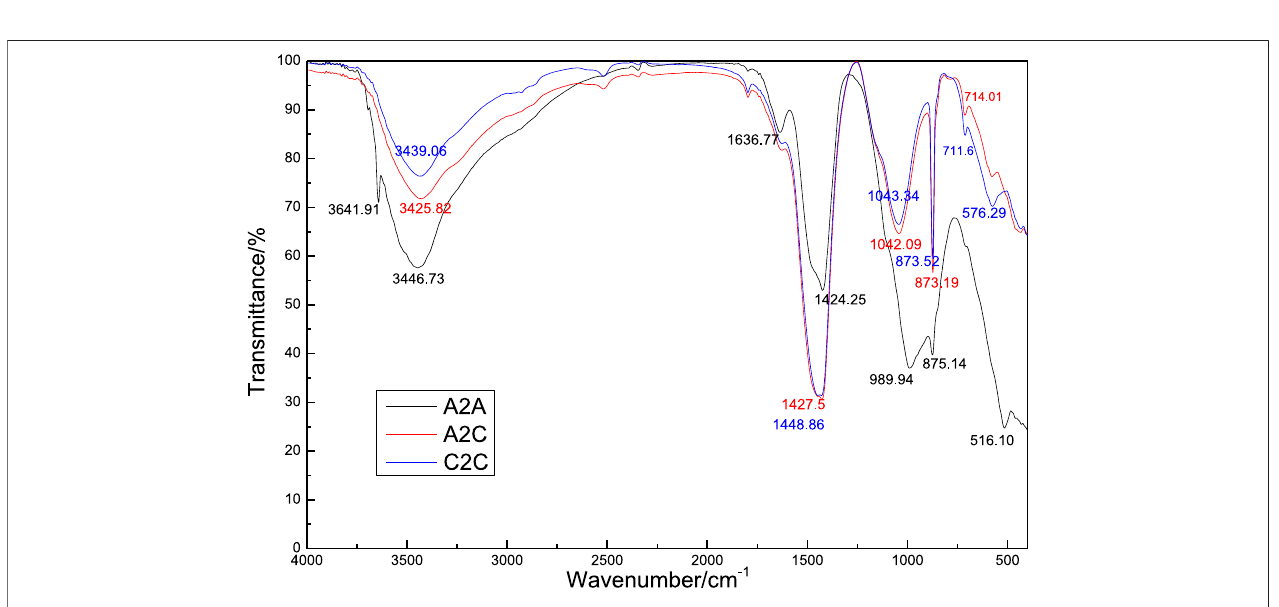
FIGURE 7 | FTIR spectra of the uncarbonated area sample from A2A-28d, carbonated area samples from A2C-1d, and C2C-1d.